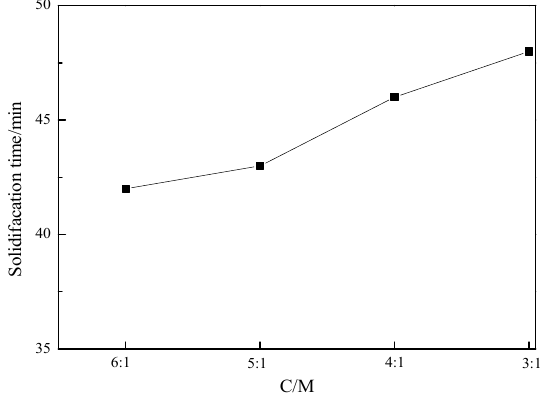
Figure 7. Effect of the ratio on the solidification aging of MKCG.